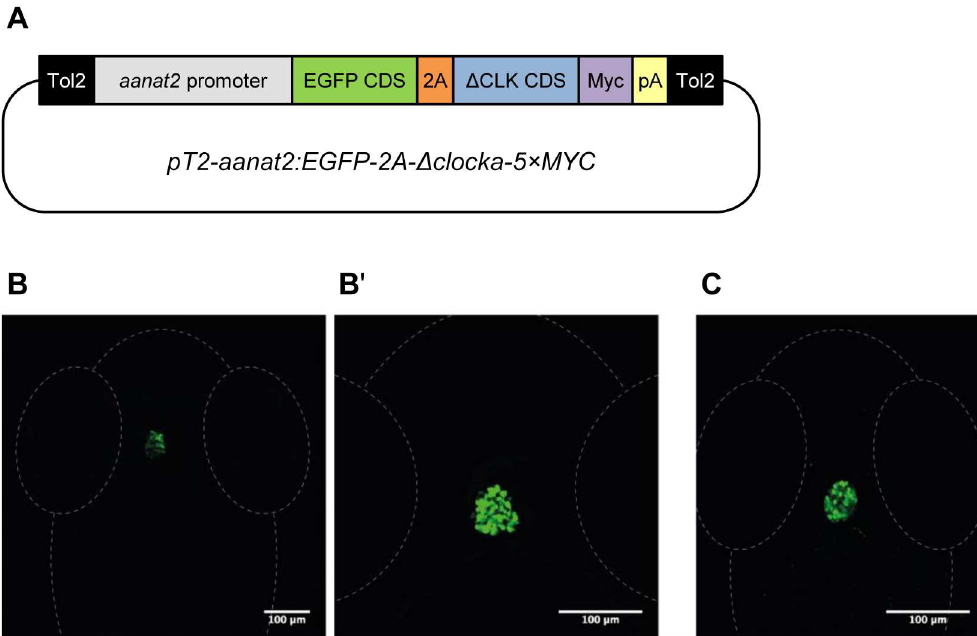
Fig 1. Generation of Tg( aanat2 :EGFP- Δ CLK) fish. (A) Schematicrepresentation of the transgenicconstruct used for the generationof Tg( aanat2 :EGFP- Δ CLK) fish. The pT2-aanat2 : EGFP-2A- Δ clocka-5 × MYC plasmid consists of two arms from the Tol2 transposable element(black), aanat2 regulatoryregions(gray), EGFP coding sequence(CDS; green), 2A peptidesequence(orange), Δ CLK CDS (blue), 5 × Myc tags (purple)and SV40 poly(A) signal(yellow). (B and B’) EGFP expressionis restricted to the pinealgland of Tg( aanat2 :EGFP- Δ CLK) larvae. Dorsal views of the head regionof 7-day post-fertilization (dpf) larvae, anterior to the top; confocalz-stack projection (B) and a single confocalplane (B’). (C) Immunostaining with anti-Myc antibodyconfirms that Δ CLK is specifically expressed in the pinealgland of Tg( aanat2 :EGFP- Δ CLK) larvae. Dorsal view of the head regionof a 5-dpf larva, anterior to the top; confocalz-stack